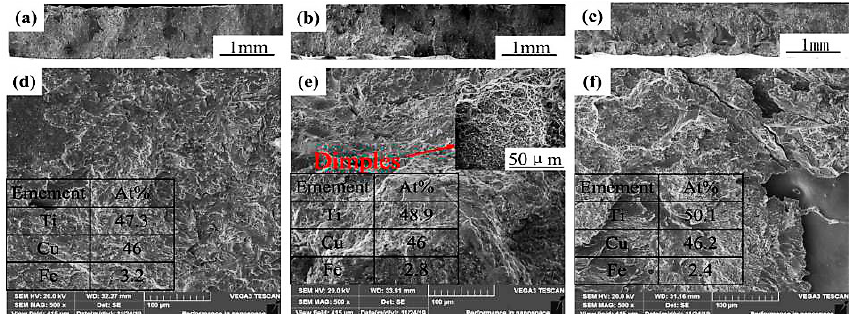
Figure 21. SEM images of tensile fracture surfaces of 301L/Cu/TA2 welded joints: ( a – c ) Overall morphology of fracture surface with offset of − 0.3 mm, 0 mm, and +0.3 mm, respectively; ( d – f ) magnified images of fracture surface with offset of − 0.3 mm, 0 mm, and +0.3 mm, respectively.